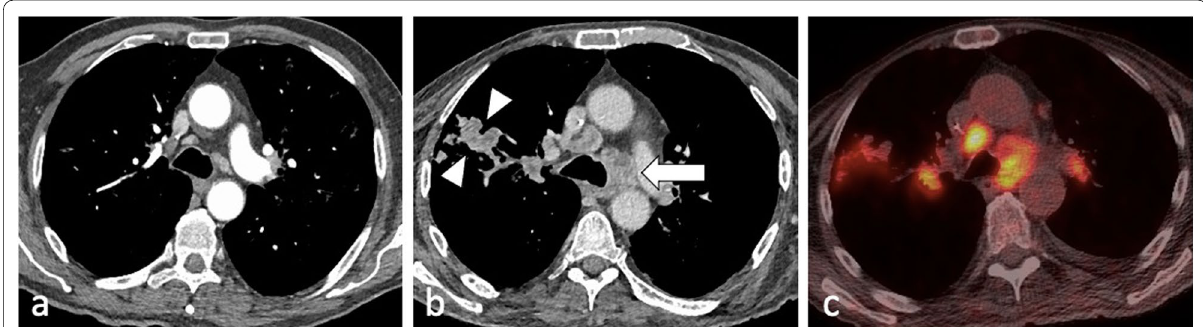
Fig. 10 A 74-year-old male with HIV and a CD4 count of 10 cells/mm 3 was started on antiretroviral therapy. He developed immune reconstitution inflammatory syndrome with worsening imaging findings in keeping with paradoxical reaction. Compared to the CT from three months prior (mediastinal window, axial plane— a ), there are enlarged centrally necrotic precarinal lymph nodes (mediastinal window, axial plane— b , arrow) and necrotic nodules in the right upper lobe (arrowheads). These were avid on PET-CT ( c